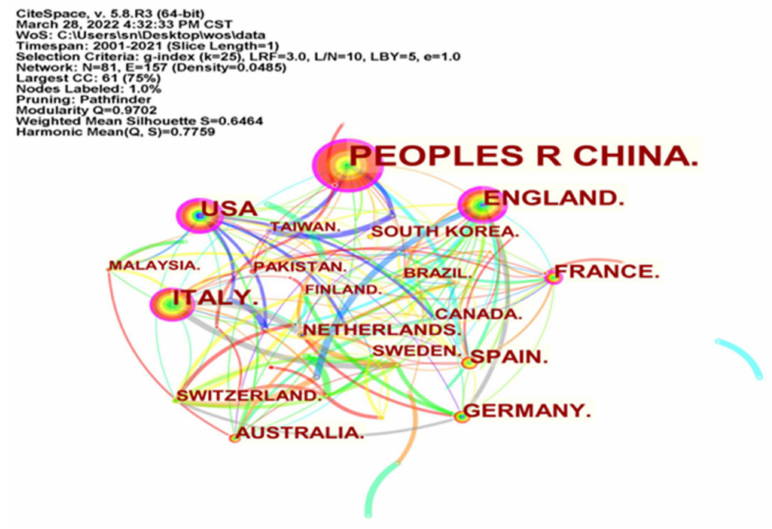
Figure 6. CiteSpace-based country (regional) cooperation mapping. Table 5. Number of papers from TOP 12 countries